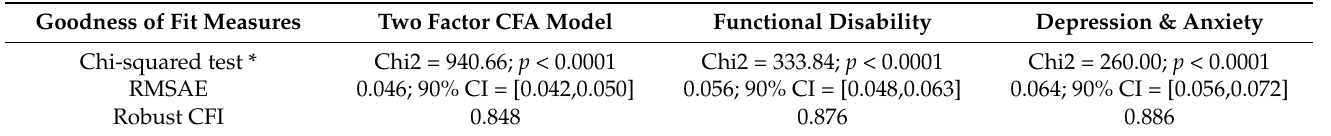
Table 3. Goodness of fit measures for the CFA model obtained by including the 5 factors obtained from EFA and the CFA models including each factor and its associated items.